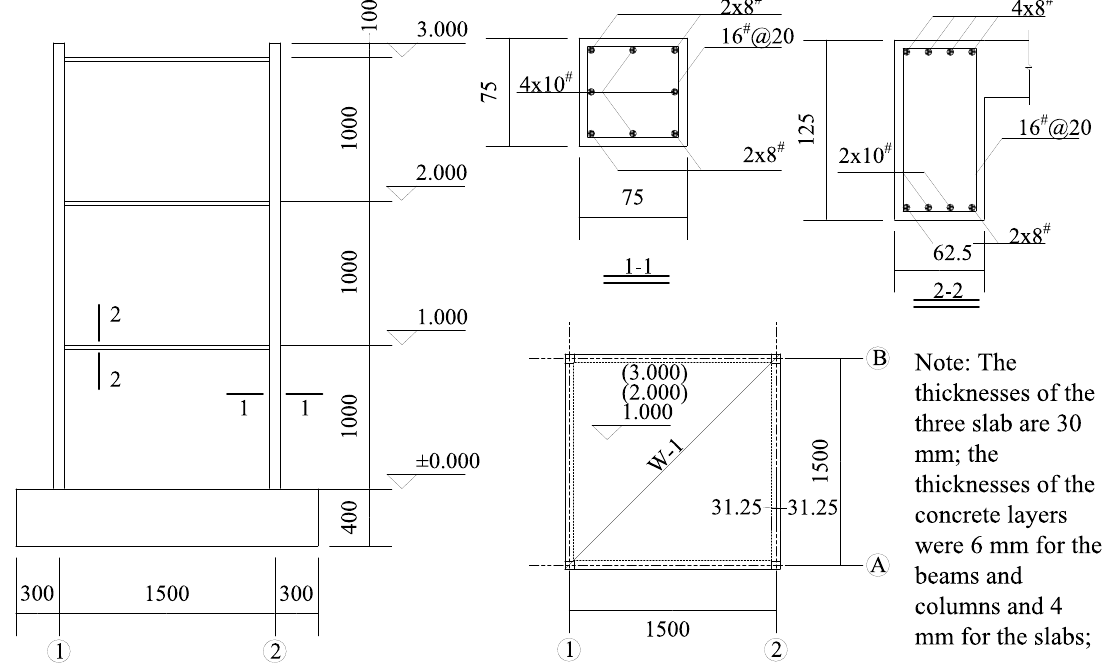
Figure 7. Dimensions and reinforcements of the model structure (units: mm). [20] (Reproduced with permission from Huang, Q., from Study on spatial collapse responses of reinforced concrete frame structures under earthquake ; published by Tongji Univerity, 2006.).